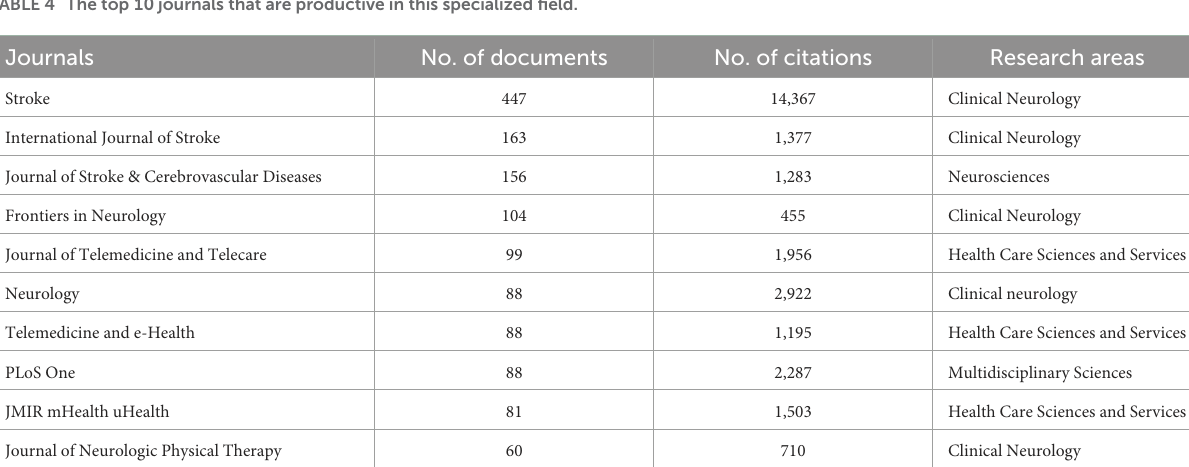
TABLE 4 The top 10 journals that are productive in this specialized